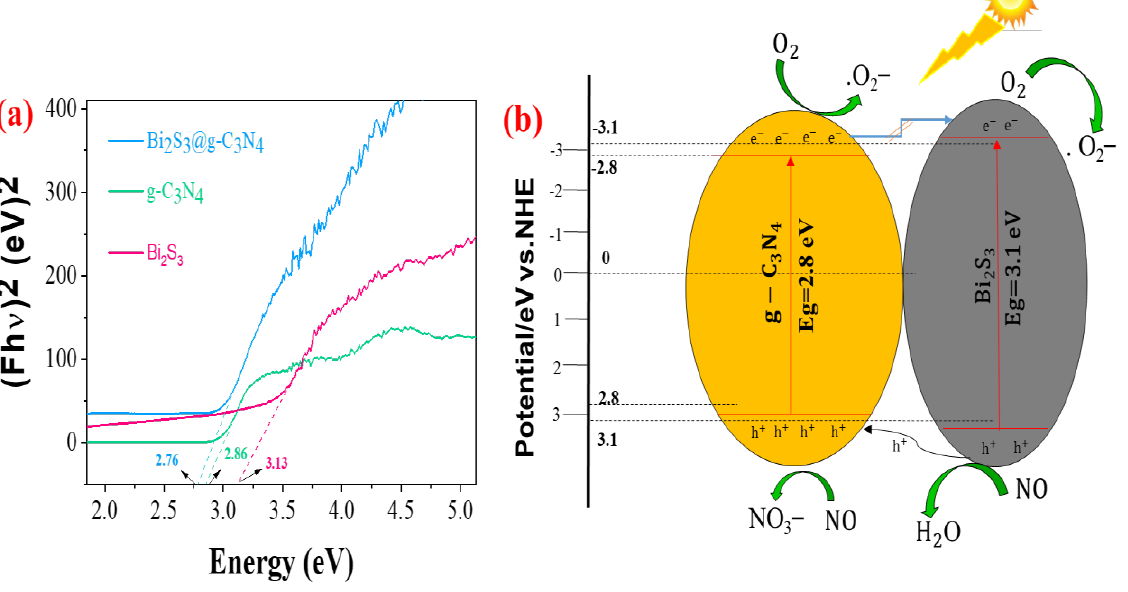
Figure 6. ( a ) Tauc plots of the synthesized materials and ( b ) the photocatalytic proposed mechanism of the Bi 2 S 3 @g-C 3 N 4 under solar irradiation.